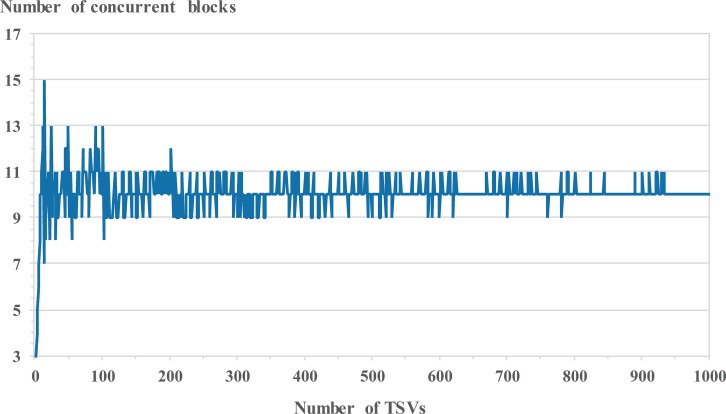
Optimized NBlock as functions of NTSV.